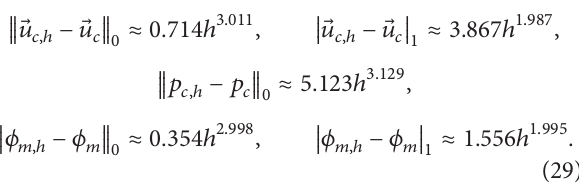
Table 1 provides errors for different choices of ℎ . Using linear regression, the errors in Table 1